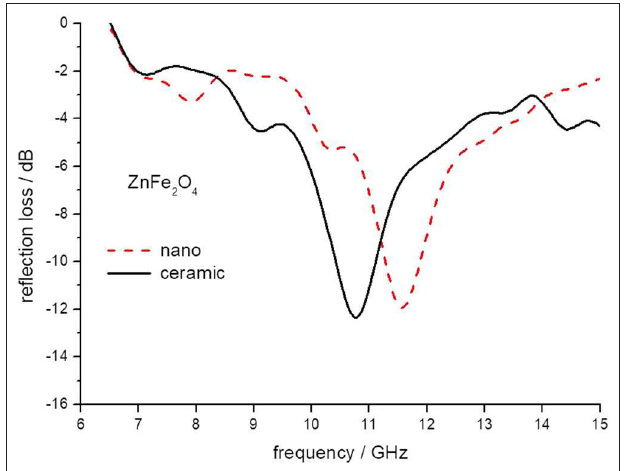
FIGURE 6 | The reflection loss of epoxy composite containing ceramic and nanoparticles of Ni 0.2 Zn 0.8 Fe 2 O 4 ferrites.